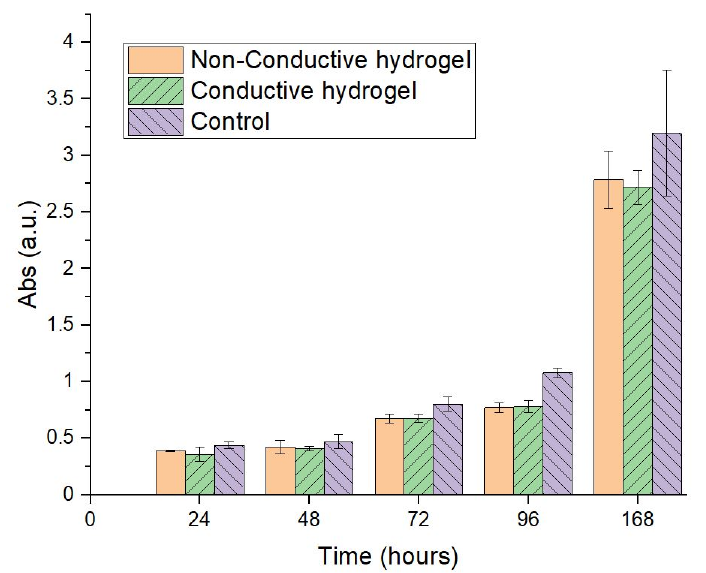
Figure 7. Cell adhesion/proliferation data.